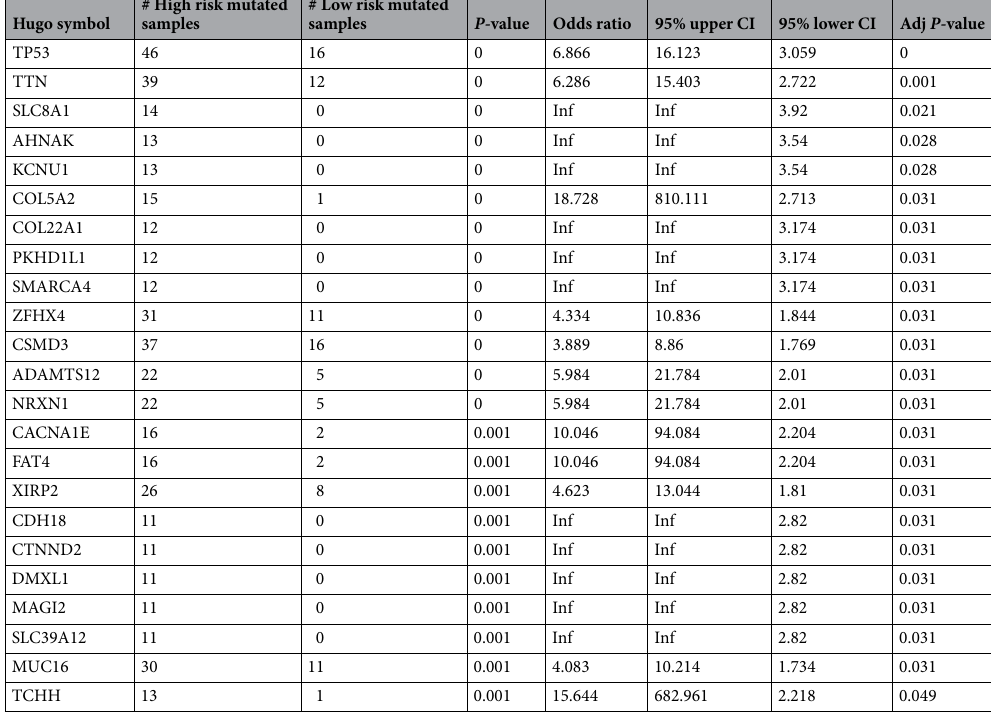
Table 2. Genes more frequently mutated in recurrence high- versus low-risk stage I lung adenocarcinomas. Twenty-three genes significantly more frequently mutated in recurrence high- versus low-risk tumors are